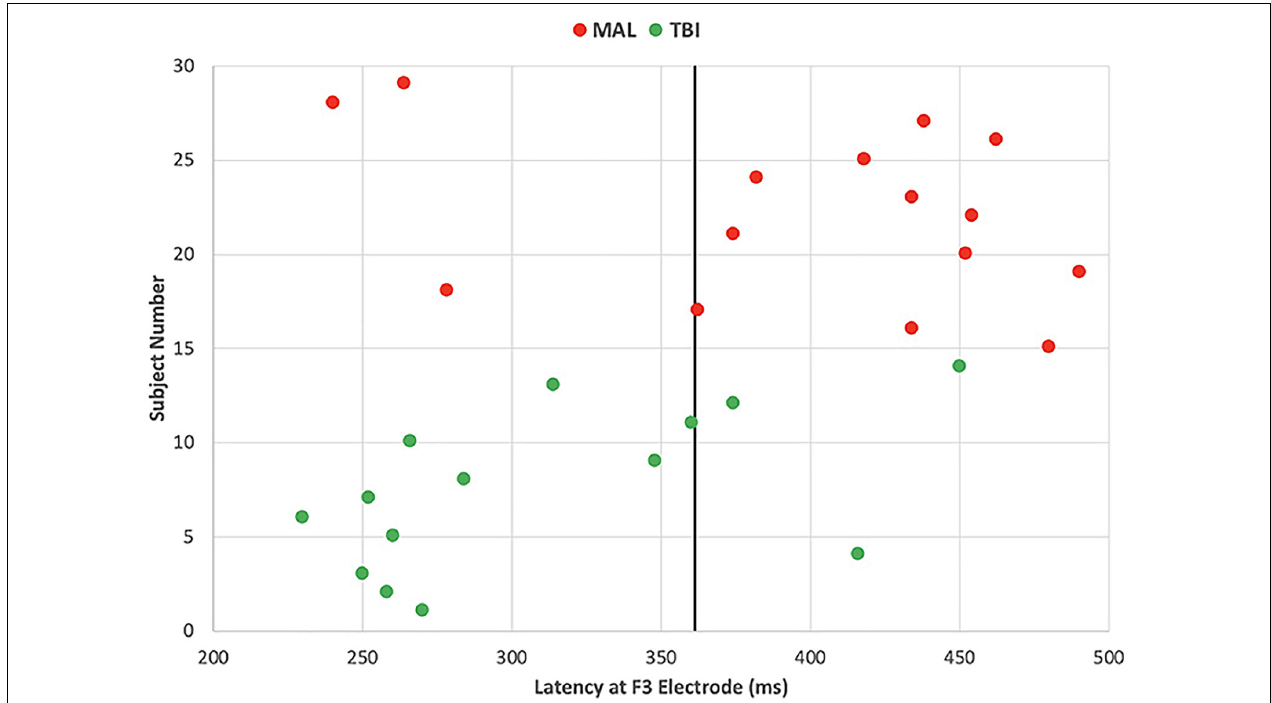
FIGURE 5 | Individual’s latency at one left frontal site differentiates malingers with 80% sensitivity and 79% of specificity. Each point represents an individual subject’s P3 latency at a left frontal (F3) site, color coded by subject groups with red representing malingering and green representing brain injured individuals. The solid black line represents the delayed latency threshold at 361